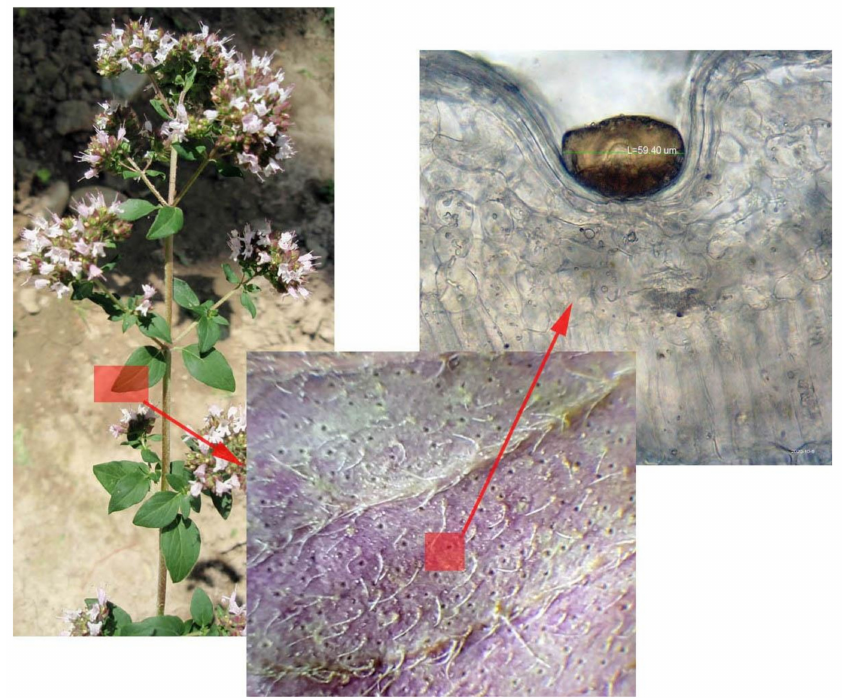
Figure 1. Origanum vulgare . Left image: flowering plant. The highlighted portion of the leaf surface is detailed in the middle image (short red arrow). Middle: Tectory and glandular trichomes on the lower leaf surface. The highlighted portion represents a secretory trichome, enlarged in the right image (long red arrow). Right: Peltate secretory trichome containing essential